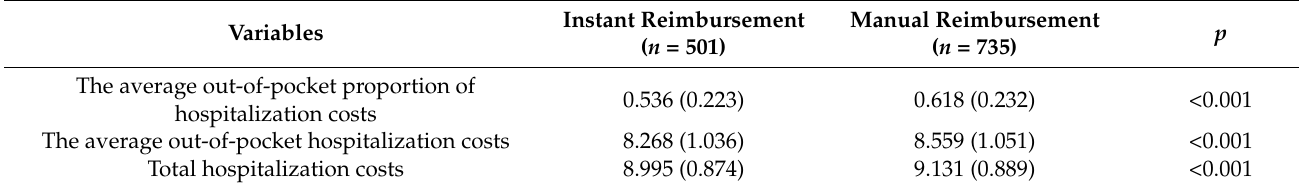
Table 2. The mean differences of hospitalization costs incurred by the floating population between instant and manual